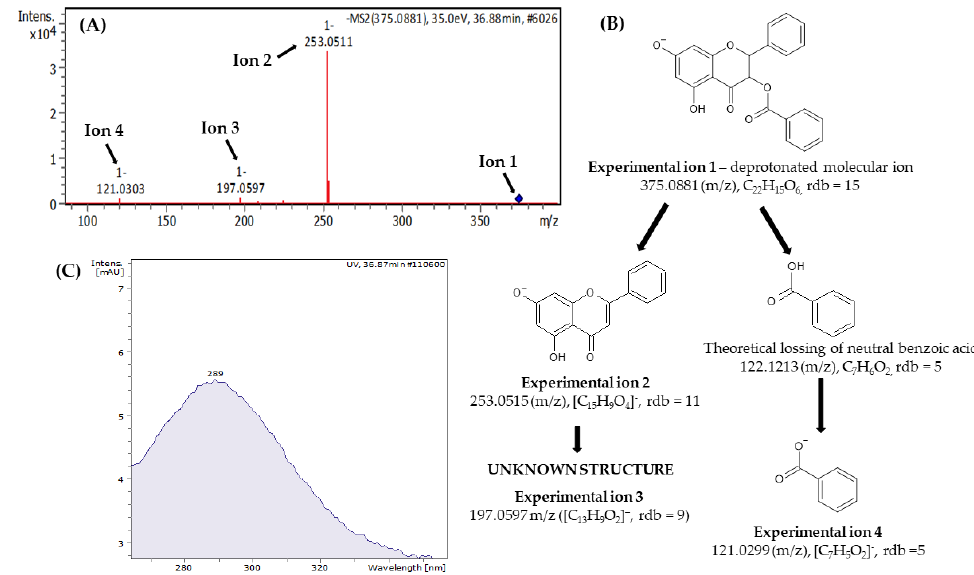
Figure 2. Experimental MS/MS ( A ) and UV ( B ) spectrum of 3 -O- pinobanksin benzoate and proposed fragmentation scheme ( C ).